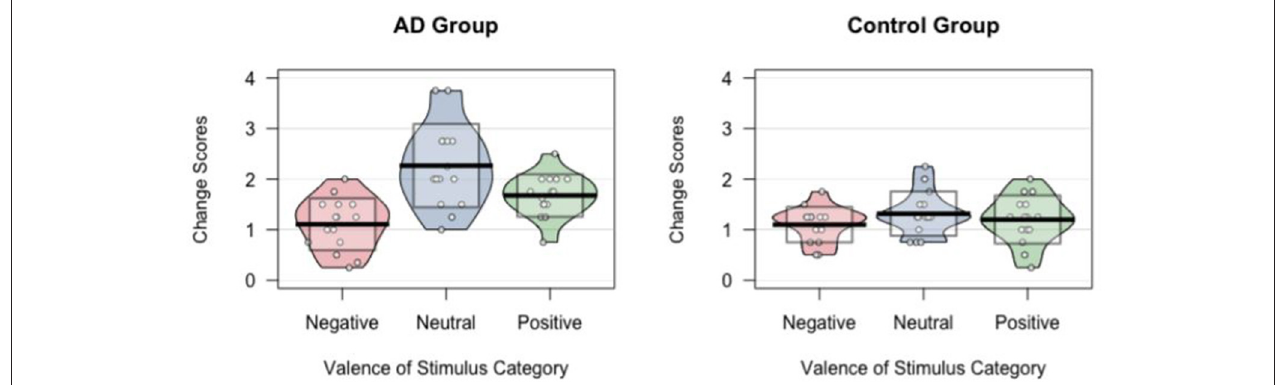
FIGURE 1 | Distributions of preference change scores shown per stimulus category and group. Each dot represents the preference change score for one participant. Noise (jitter) was added horizontally to reduce overlap among points with similar value. Horizontal black lines indicate means. Standard deviation of the mean of preference change scores for each valence category are indicated as transparent